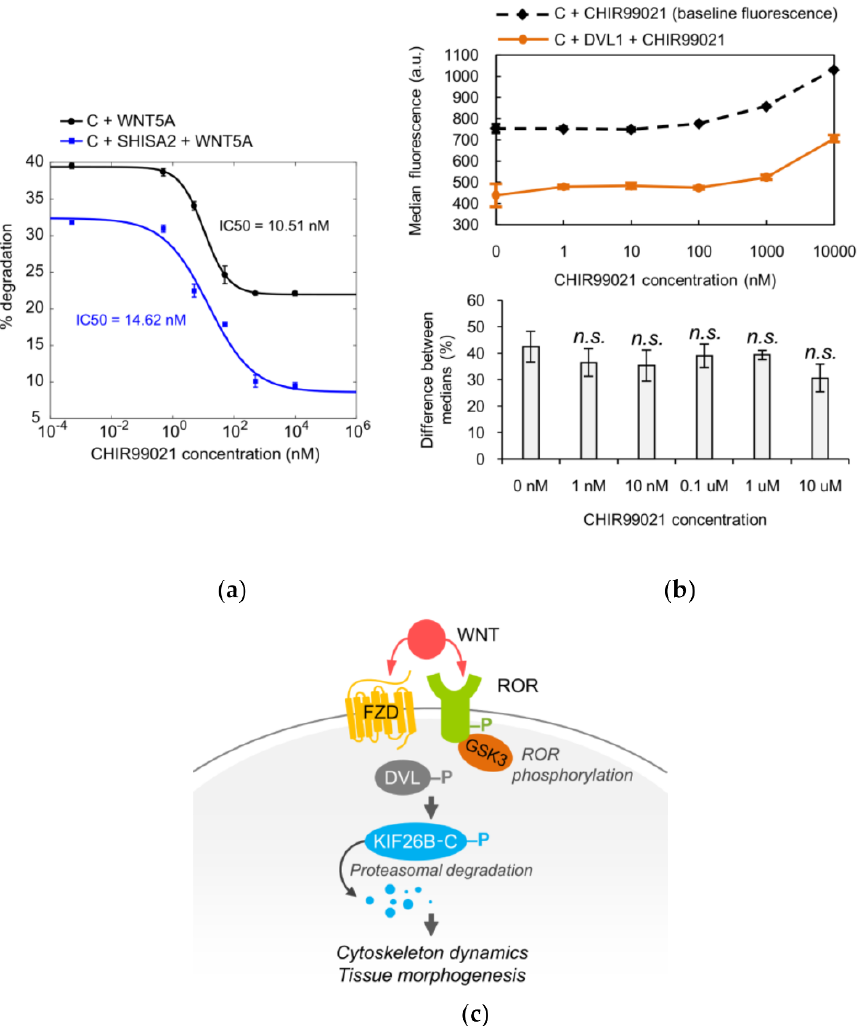
Figure 4. Glycogen synthase kinase 3 (GSK3) is part of the WNT5A signaling cascade that controls KIF26B-C degradation. ( a ) Dose-response curves showing WNT5A-induced GFP-KIF26B-C (C) degradation as a function of CHIR99021 (GSK3 inhibitor) concentration, without or with SHISA2 expression in the reporter cells. Error bars represent ± SEM calculated from independent replicates ( n = 3 for each experimental condition); ( b ) Top : Median fluorescence vs. CHIR99021 concentration for GFP-KIF26B-C (baseline fluorescence) and GFP-KIF26B-C fluorescence resulting from DVL1-induced degradation (a.u. = arbitrary units). Bottom : quantification of the percent difference between DVL1-induced fluorescence and baseline medians for each concentration. Error bars represent ± SEM calculated from independent replicates ( n = 6 for each experimental condition). For the quantification, statistical analysis was performed with unpaired t -test ( n.s. = not significant vs. 0 nM); ( c ) Model of the role of GSK3 in FZD-ROR receptor